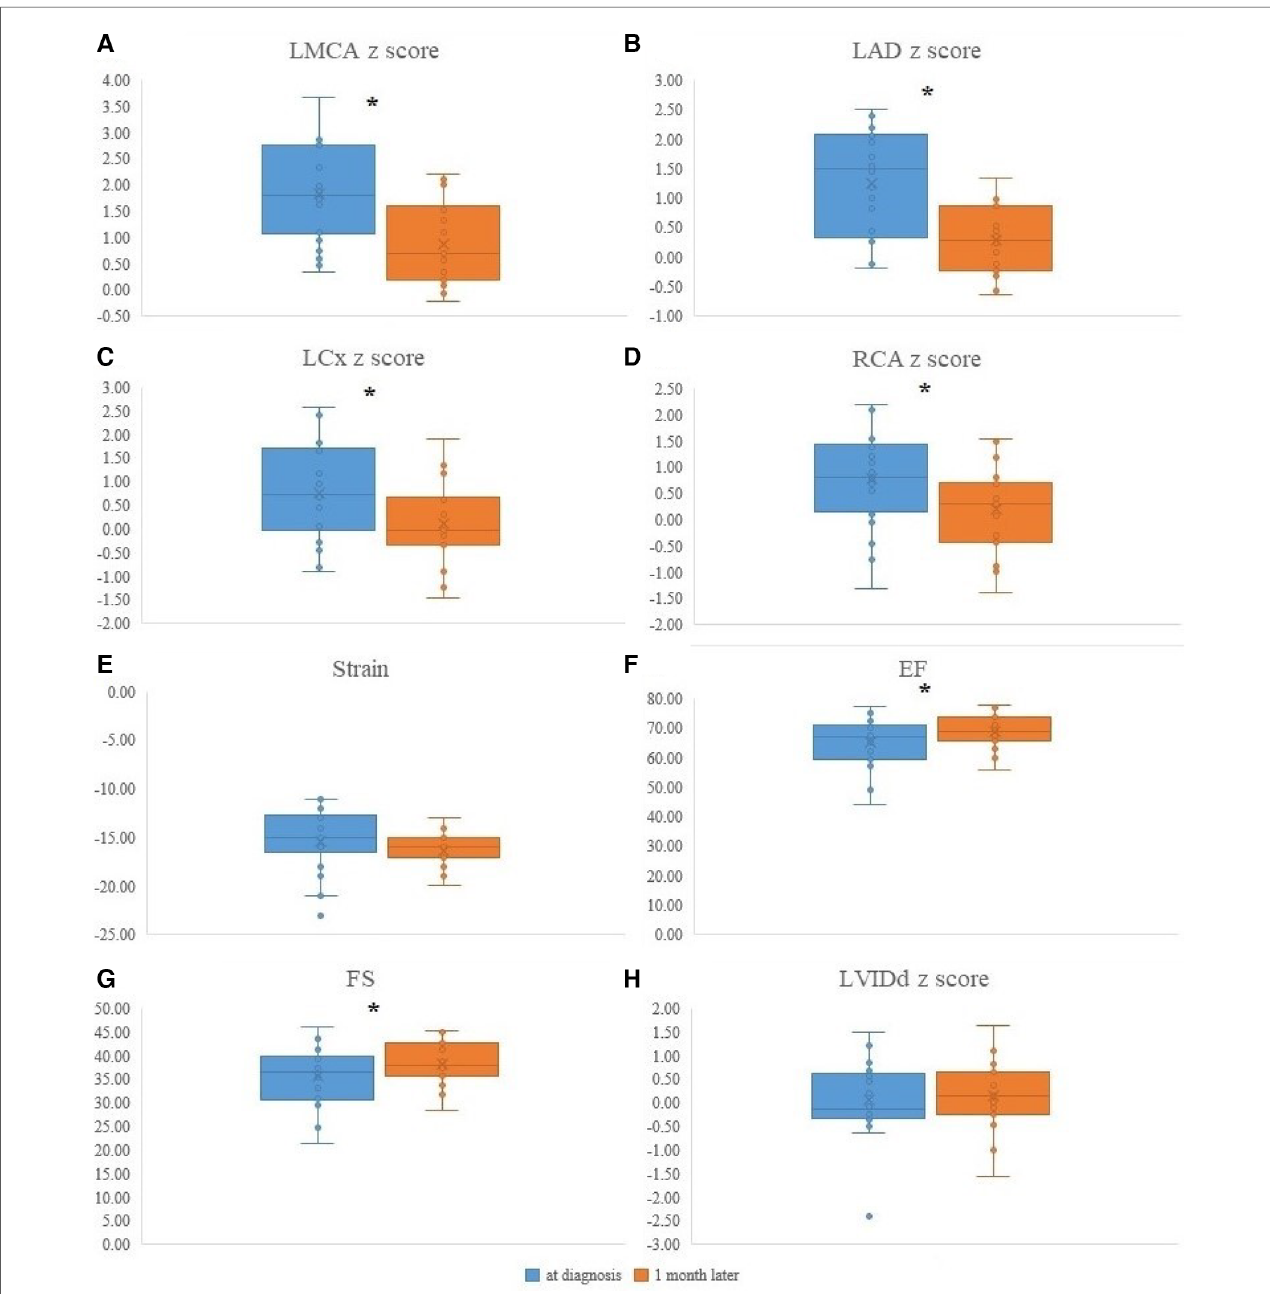
FIGURE 3 The echocardiographic data of MIS-C patients at diagnosis and 1 month after MIS-C diagnosis. ( A ) LMCA z -score changes at diagnosis and 1 month after diagnosis (1.8±1.0 to 0.9±0.8, P< 0.001). ( B ) LAD z -score changes at diagnosis and 1 month after diagnosis (1.2±0.9 to 0.3±0.6, P <0.001). ( C ) LCx z - score changes at diagnosis and 1 month after diagnosis (0.8±1.1 to 0.1±0.9, P =0.008). ( D ) RCA z -score changes at diagnosis and 1 month after diagnosis (0.8±0.8 to 0.2±0.8, P =0.017). ( E ) Apical 4-chamber LV longitudinal strain changes at diagnosis and 1 month after diagnosis ( − 15.6±3.5 to − 16.4±1.7, %, P =0.359). ( F ) EF changes at diagnosis and 1 month after diagnosis (64.8±8.6 to 68.9±6.1, %, P =0.035). ( G ) LV FS changes at diagnosis and 1 month after diagnosis (35.4±6.4 to 38.4±4.7, %, P =0.046). ( H ) LVIDd z -score changes at diagnosis and 1 month after diagnosis (0.2±0.6 to 0.2±0.8, P =0.889). LMC, Left main coronary artery; LAD, Left anterior descending artery; LCx, Left circum fl ex artery; RCA, Right coronary artery; LV, Left ventricle; A4C, Apical 4 chamber; EF, Ejection fraction; FS, Fractional shortening; LVIDd, diastolic left ventricular internal diameter. * P